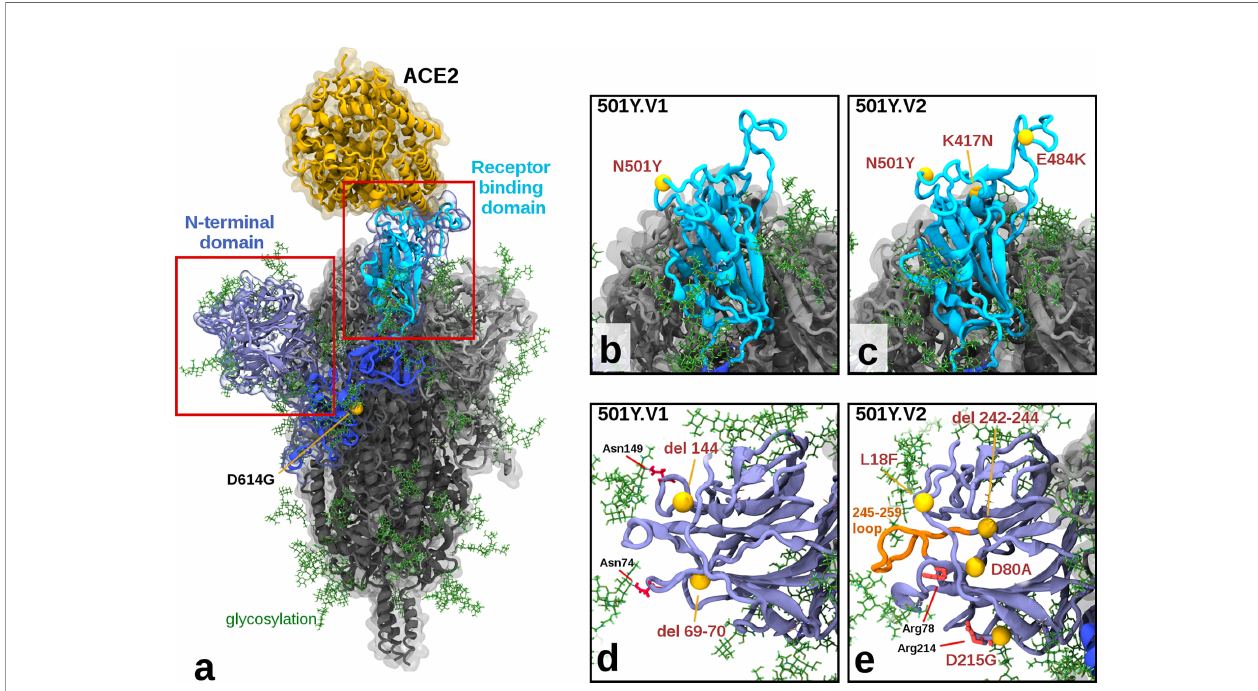
FIGURE 2 | Illustration of Mutations in 501Y.V1 and 501Y.V2 Relative to the Ancestral Form. (A) Structure of the glycosylated SARS CoV2 Spike protein highlighting a S1 monomer (in blues) and relative positions of the N terminal domain (NTD) and the receptor-binding domain (RBD) and the bound ACE2 receptor (in yellow). The position of D614G (common to all tested variants) is also highlighted. (B, C) Side by side comparison of 501Y.V1 and 501Y.V2 variants in the RBD, showing the V2 variant having additional K417N and E484K mutations. (D, E) Side by side comparisons of 501Y.V1 and 501Y.V2 variants in the NTD, showing relative locations of mutations and deletions. (Model fi les available in Supplementary Material